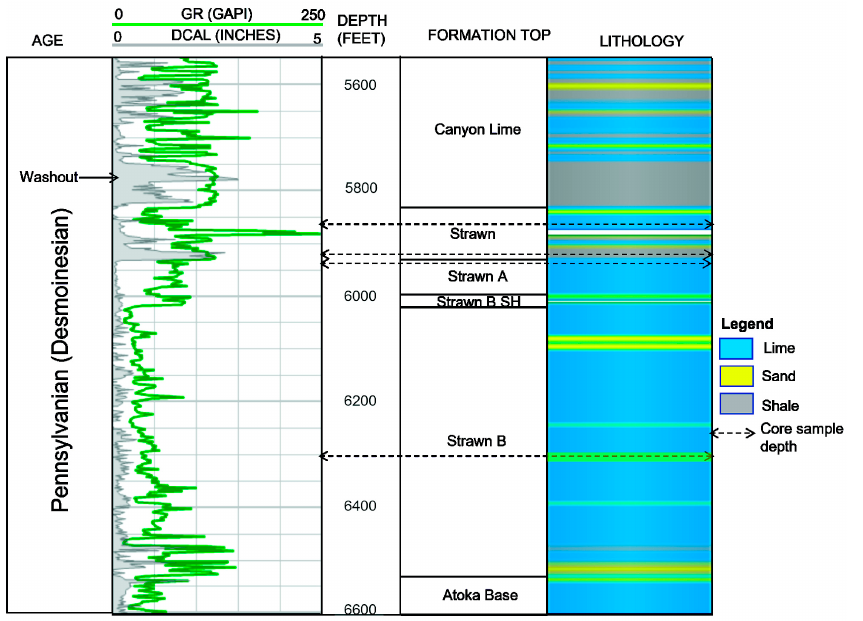
Figure 2. Stratigraphic section taken at well location showing some subdivisions within Strawn interval.